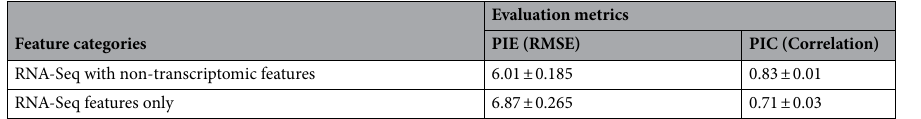
Table 3. Results of the proposed dense vanilla model with and without non-transcriptomic input features.